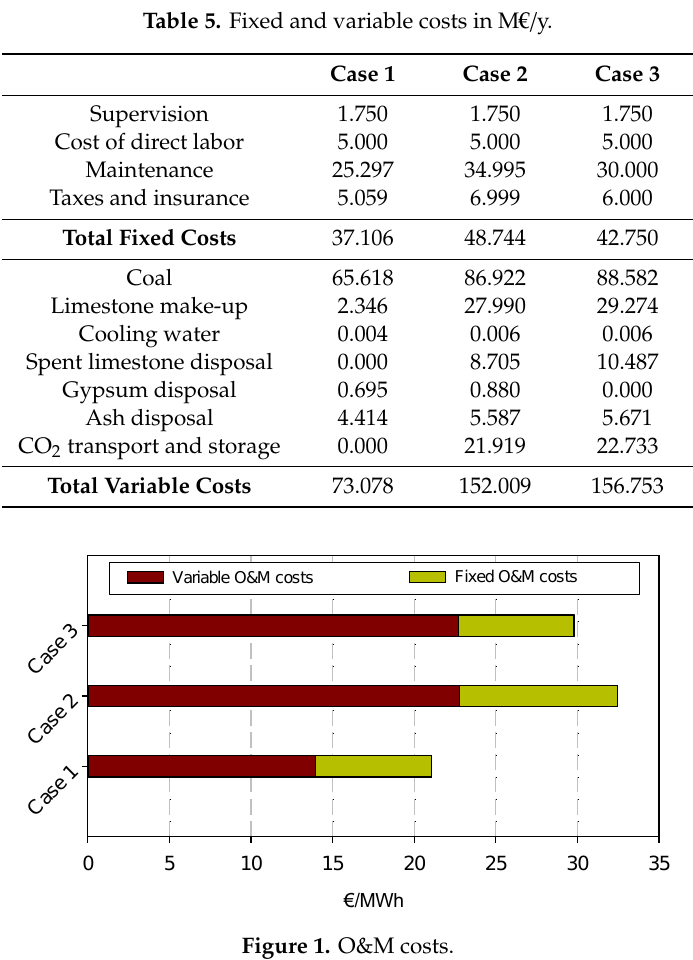
Table 5. Fixed and variable costs in M€/y .